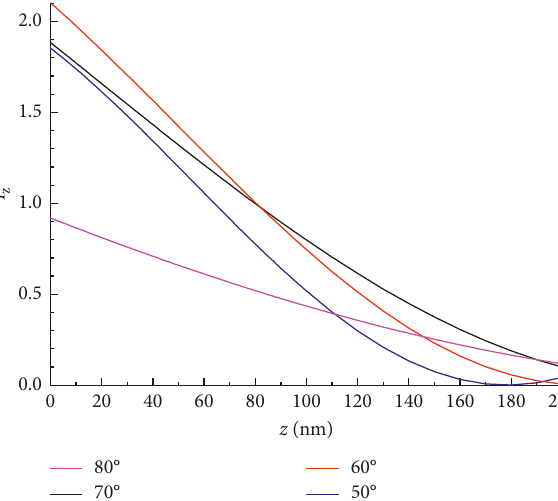
Figure 3: Intensity of the transverse field component versus the distance to a gold surface illuminated at different angles by p -polarized light with the wavelength of 632.8 nm.